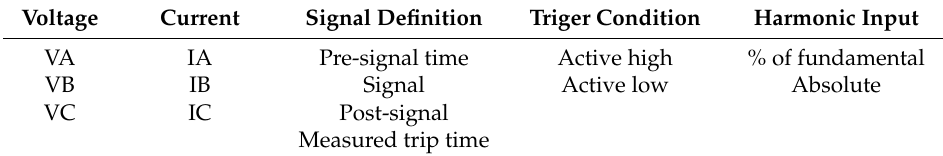
Table 2. Harmonic testing conditions Omicron.